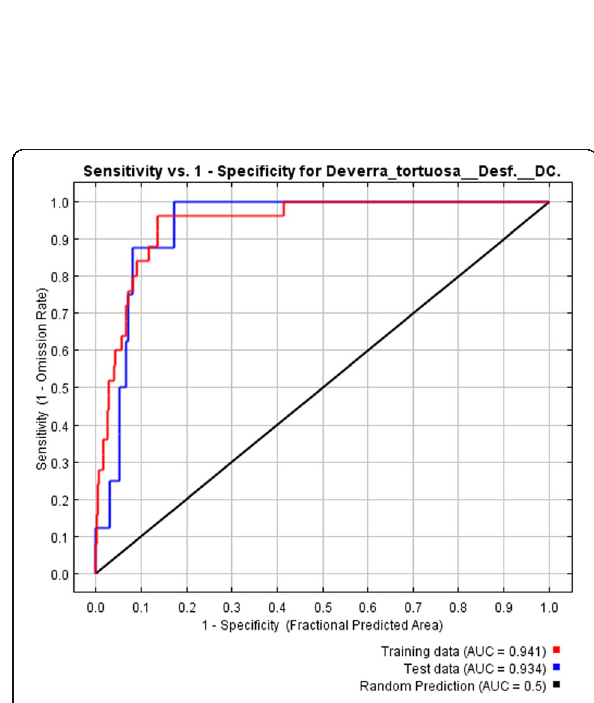
Fig. 9 Training data (AUC = 0.941) and test data (AUC = 0.934) compared to random prediction (AUC = 0.5) in the receiver operating characteristic (ROC) curve for the representation of the MaxEnt model for D.